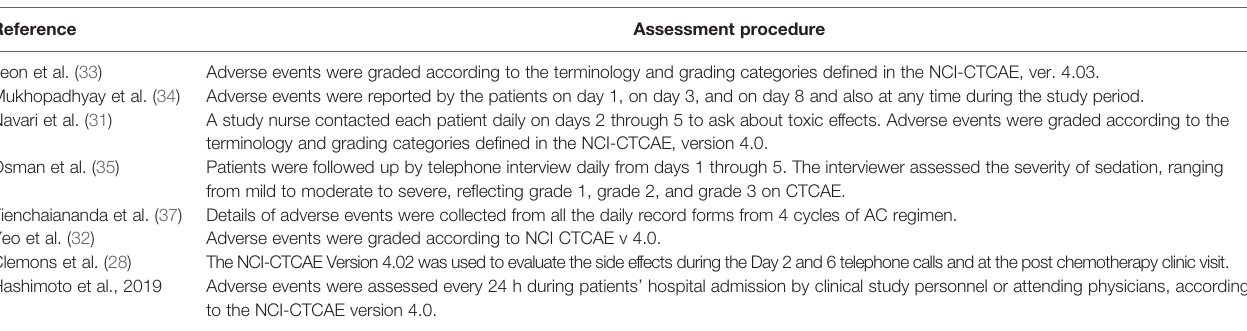
TABLE 2 | The procedures to evaluate the sedative effect of